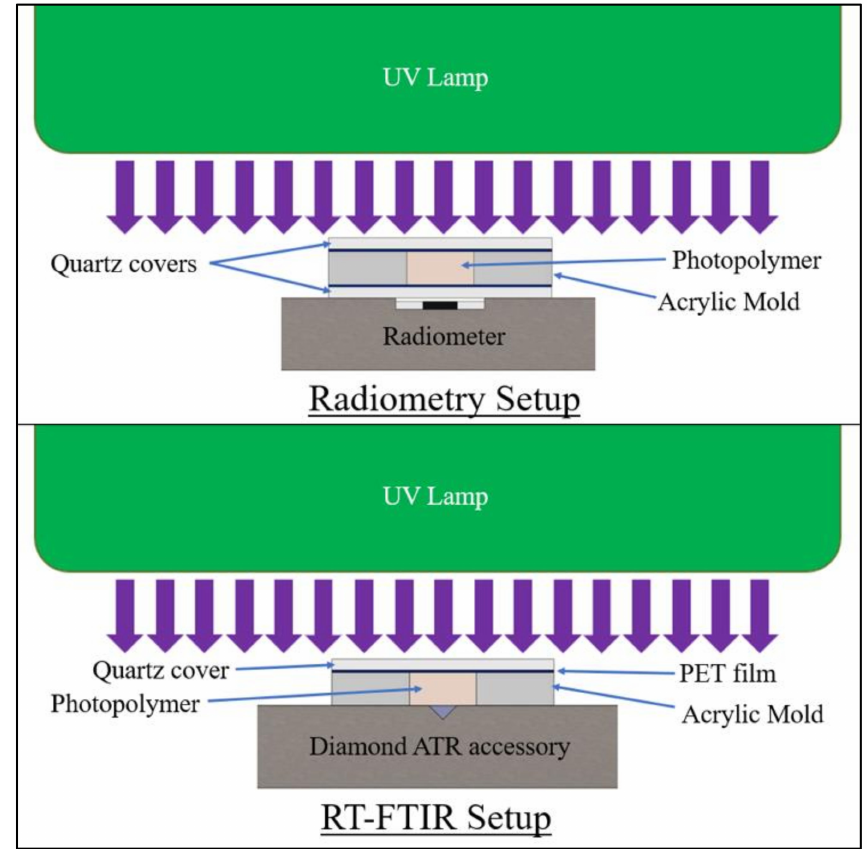
Figure 4. Specimen setup for 60 s irradiation testing at 3-mm specimen